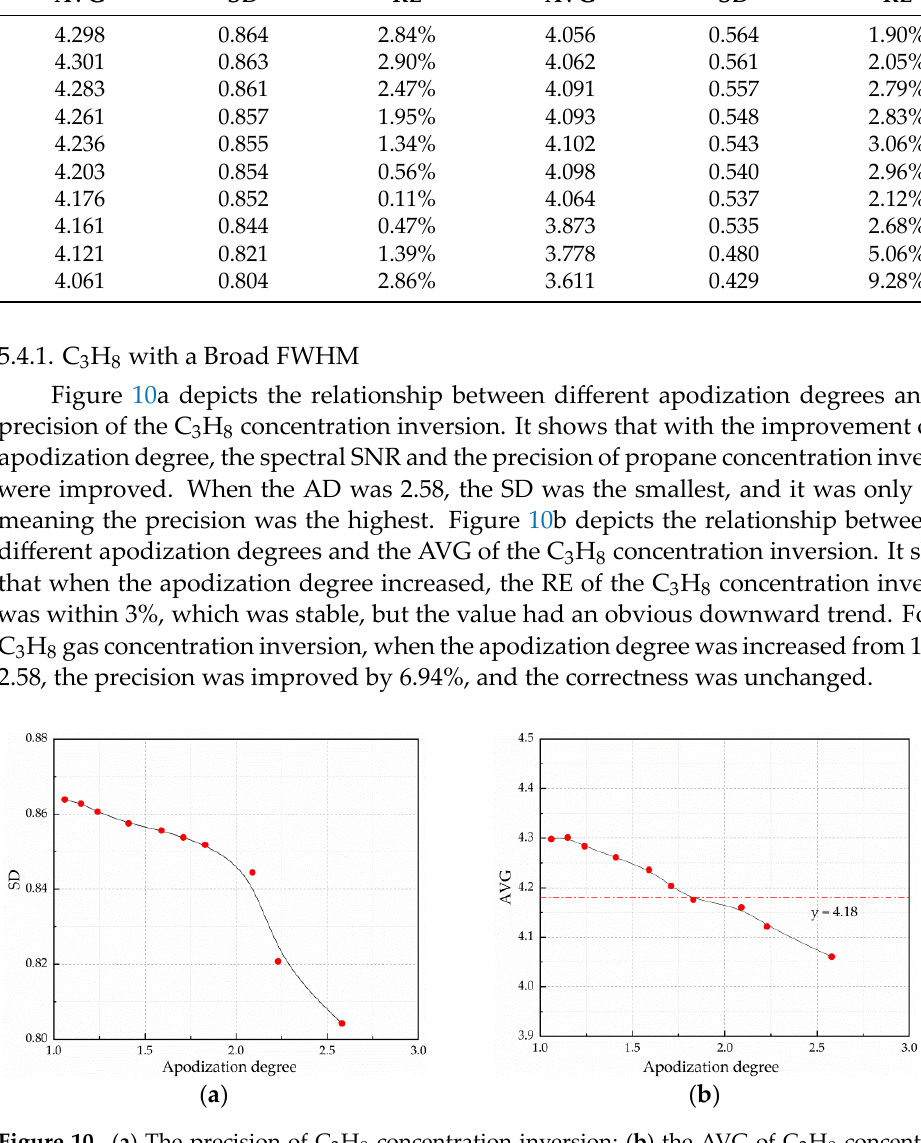
Figure 10. ( a ) The precision of C 3 H 8 concentration inversion; ( b ) the AVG of C 3 H 8 concentration